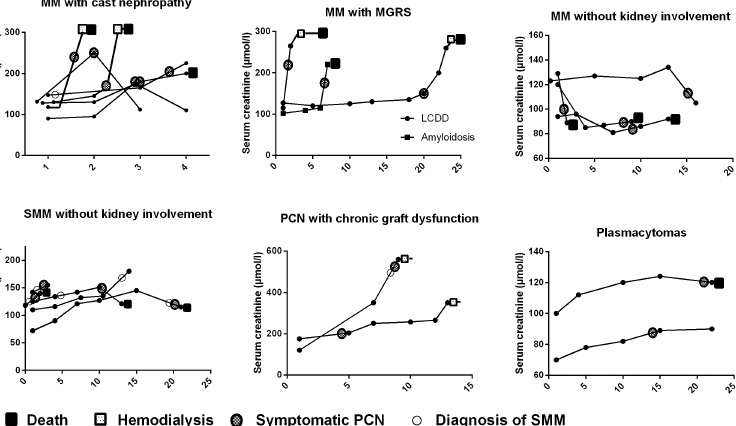
Fig 4. Evolution of serum creatinine after kidney transplantation, combined with the occurrence of asymptomatic or symptomatic PCN, hemodialysis and death for each patient. Evolution of serum creatinine ( μ mol/l)over time (in years) after kidney transplantation, for each patient. Patients were classifiedin six groups, and approximate time of diagnosis of SMM (smolderingmultiplemyeloma), symptomatic PCN (plasma-cell neoplasia), hemodialysis and death were added. MM: MultipleMyeloma. MGRS: Monoclonal Gammapathy of Renal Significance. LCDD: Light Chain DepositionDisease.